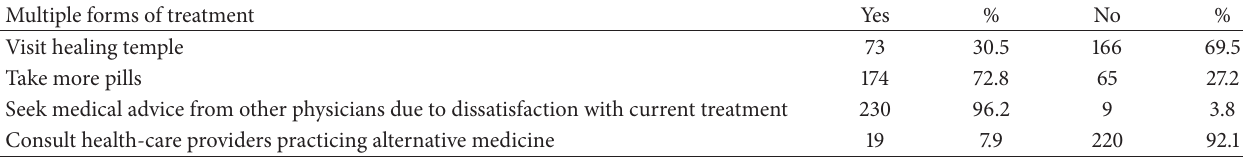
Table 5: Multiple forms of treatment as reported by patients ( 𝑁 = 239 ).